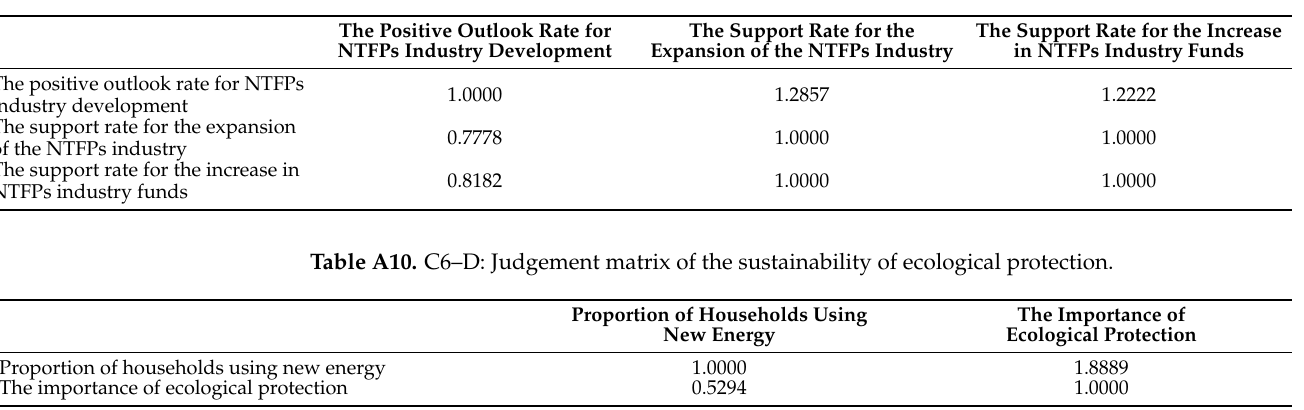
Table A9. C5–D: Judgement matrix of the sustainability of NTFPs industry.